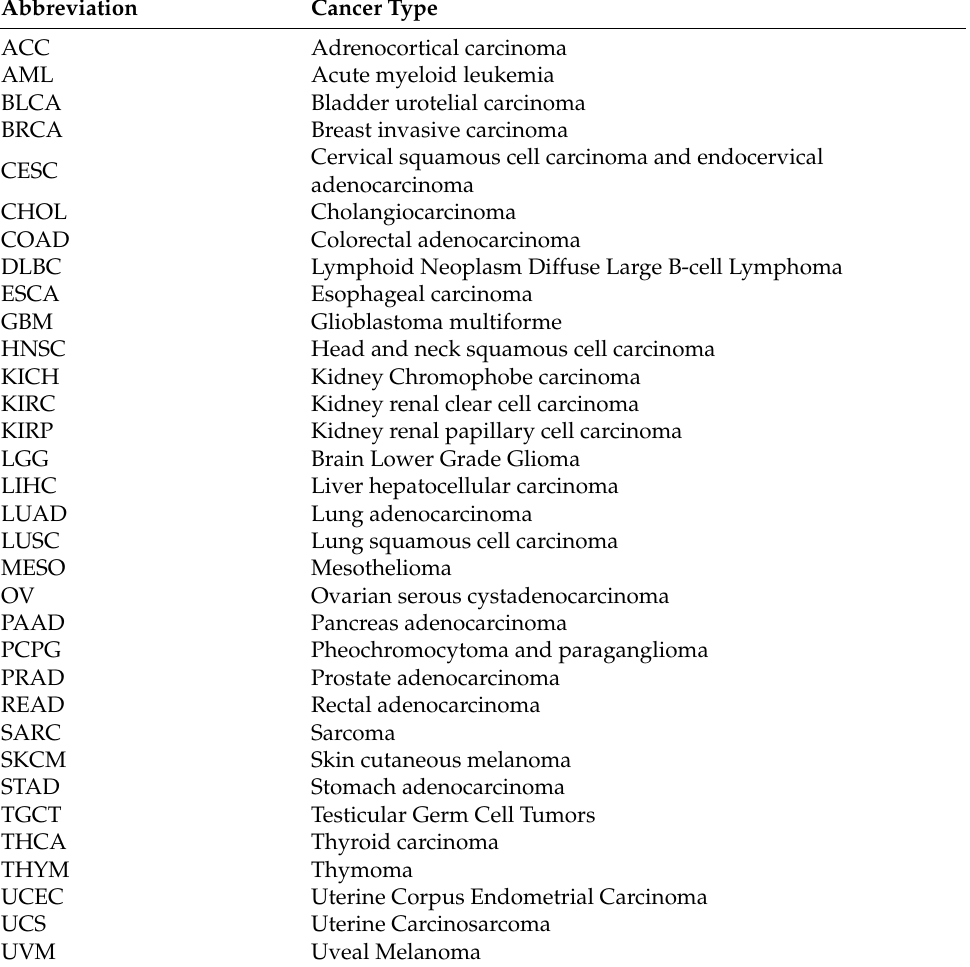
Table 1. List of cancer